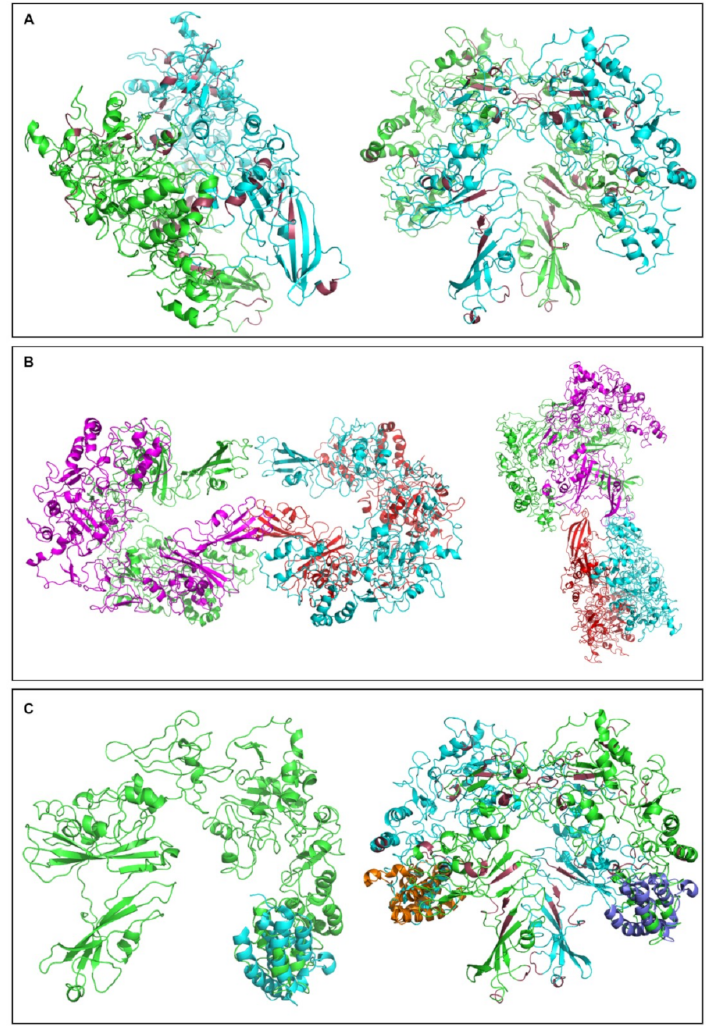
Figure 9. CA1ICL-861 can in silico generate dimers and tetramers, and also obtain a bromodomain-like structure. ( A ) Molecular model (best views), via HADDOCK2.2 engagement, of the predicted CA1ICL-861 homodimer. The “H”-like (left panel) and “tree”-like (right panel) structures are illustrated. Each monomer is presented with different color. The raspberry color indicates the “LLTS” tetrapeptide repeats. Note the molecular symmetry of the complex. ( B ) Molecular model (best views), through HADDOCK2.2 employment, of the in silico structured CA1ICL-861 homotetramer. Each monomer is pictured with different color. Note the remarkable molecular symmetry of the complex (left panel). ( C ) Structural alignment (best views), by PyMol “Align Command” utilization, of the CA1ICL-861 monomer (left panel) or dimer (right panel) with chain A of human CBP bromodomain (experimentally determined structure; PDB ID: 4OUF). CBP bromodomain is illustrated with light blue (left panel: CA1ICL-861 monomer) or a slate and orange (right panel: CA1ICL-861 dimer) color. Each monomer is shown with different color (right panel). The raspberry color indicates the “LLTS” tetrapeptide repeats (right panel). Note the partial, but significant, superposition of CBP bromodomain on CA1ICL-861 modeled structure. Also, observe the 2:2 molecular stoichiometry between the structurally aligned CA1ICL-861 dimer and CBP bromodomain protein models (right